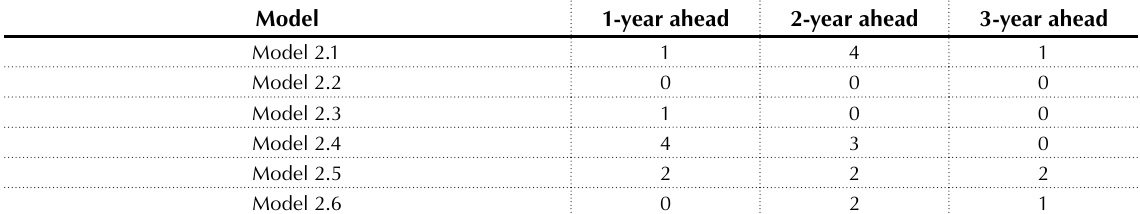
Table 9. Type I error of SVM models (%)